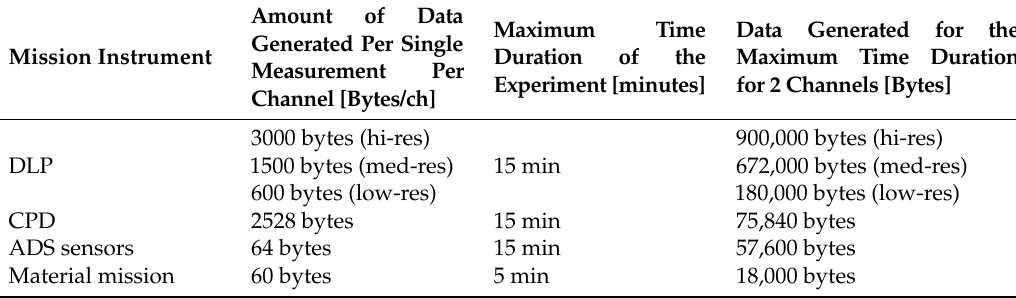
Table 4. Data generation for the main mission instruments as a function of the duration of each experiment for one ground station access